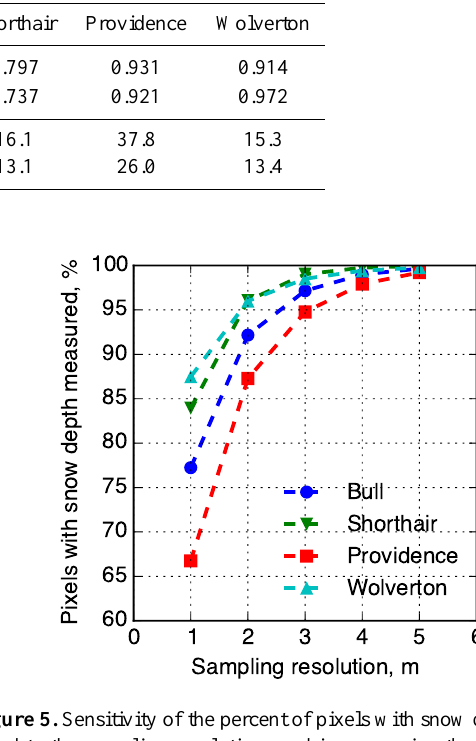
Table 3. Linear-regression results, averaged snow depth vs. elevation at four sites.